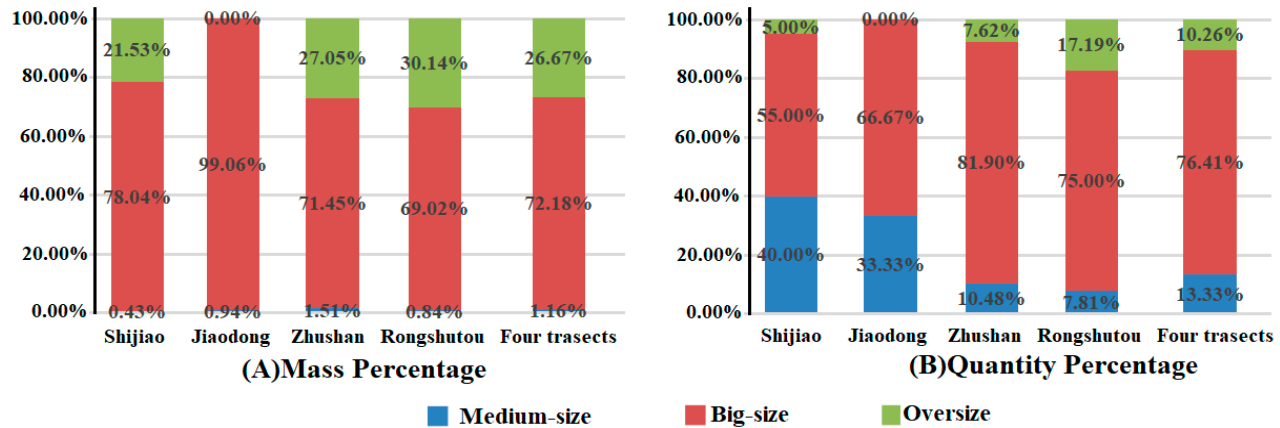
Figure 5. The percentages of medium-size, big-size and oversize debris. Table 6. Mass weights and quantity of marine debris items by sizes.